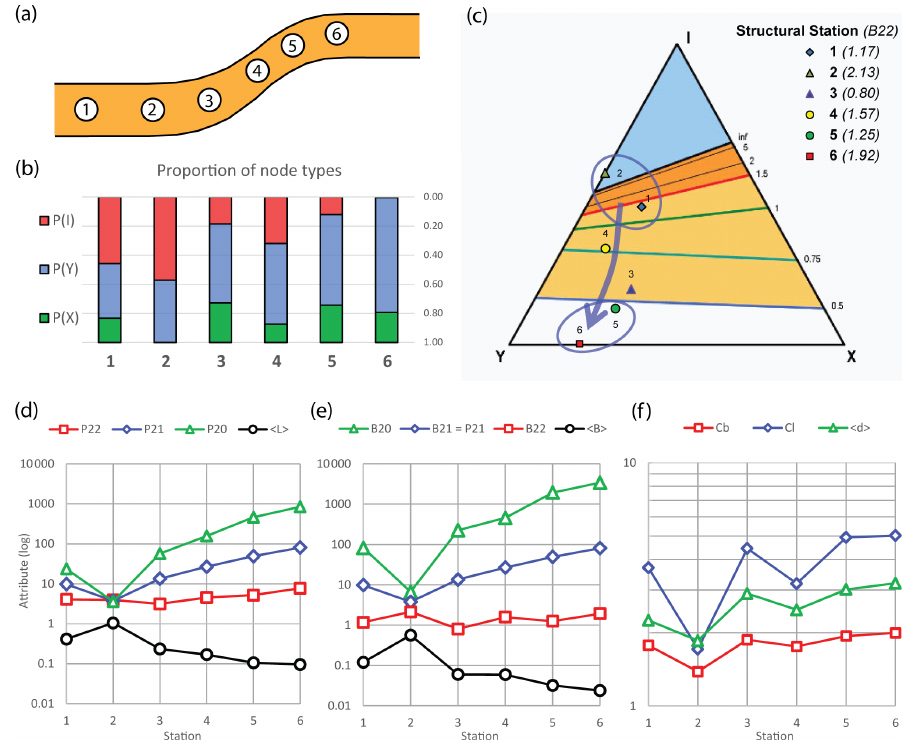
Figure 7. Nodal and fracture analysis results. (a) Schematic diagram showing relative location of each structural station across the monoclinal intrusion margin. (b) Bar chart showing spatial variation in nodal populations. (c) Triangular plot showing ratio of I-, Y- and X-nodes for total values for each station. Contours represent the branch dimensionless intensity ( B 22 ) of a network with that nodal topology when it is at the percolation threshold (i.e. the limit or threshold at which the network is “unconnected”/“connected”). If the network has a higher B 22 than in the contour plot then the network is considered connected; conversely if lower it is considered unconnected. As the B 22 values for Stations 1 and 2 (see Table 1 and values in key) are below the contour values, these deformation band networks are clearly unconnected, whereas Stations 4, 5 and 6 are well above the contour values and thus may be considered well connected. For more details on the triplot template, see Sanderson and Nixon (2018). (d–f) Summary plots showing the log of various fracture attributes at each station (see Table 1 for values). − 2 ; number of lines/sample area): line intensity (cid:104) L (cid:105) : Mean line length (m; total line length/number of lines); P 20 : line frequency; P 21 (m (m − 1 ; total line length/sample area); P 22 : line dimensionless intensity (multiplying line intensity by the mean length); (cid:104) B (cid:105) : Mean